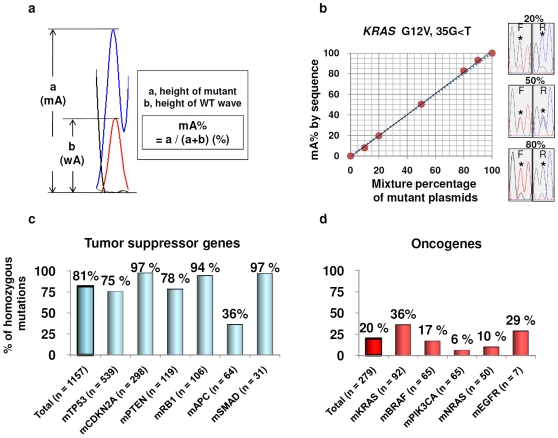
Homozygous mutations (complete MASI) of oncogenes are frequent.Quantitation of mutant allele (mA) by direct sequencing (a and b). wA, wild type allele; WT, wild type; mA%, proportion of mutant allele. a) Calculation method of mA% in point mutations by sequencing eletcropherogram is shown. b) An example of accuracy of mutant allelic quantitation (mA%) by measurement of sequencing electropherogram (KRAS mutation: G12V, 35G<T; results of forward reading is shown). We performed similar experiments for 14 kinds of mutations of KRAS, BRAF, PIK3CA or EGFR genes and confirmed the accuracy of mA% by measurement of sequencing electropherograms. F, forward sequencing; R, reverse sequencing c) and d) Frequency of homozygous mutations of 11 well-described tumor related genes in 833 cancer cell lines collected at Cancer Genome Project, Welcome Trust Sanger Institute (www.sanger.ac.uk/). As expected, homozygous mutations are frequent in six tumor suppressor genes (c). Those of five oncogenes are also relatively frequent (d). MASI, mutant allele specific imbalance; The prefix m- means mutant.